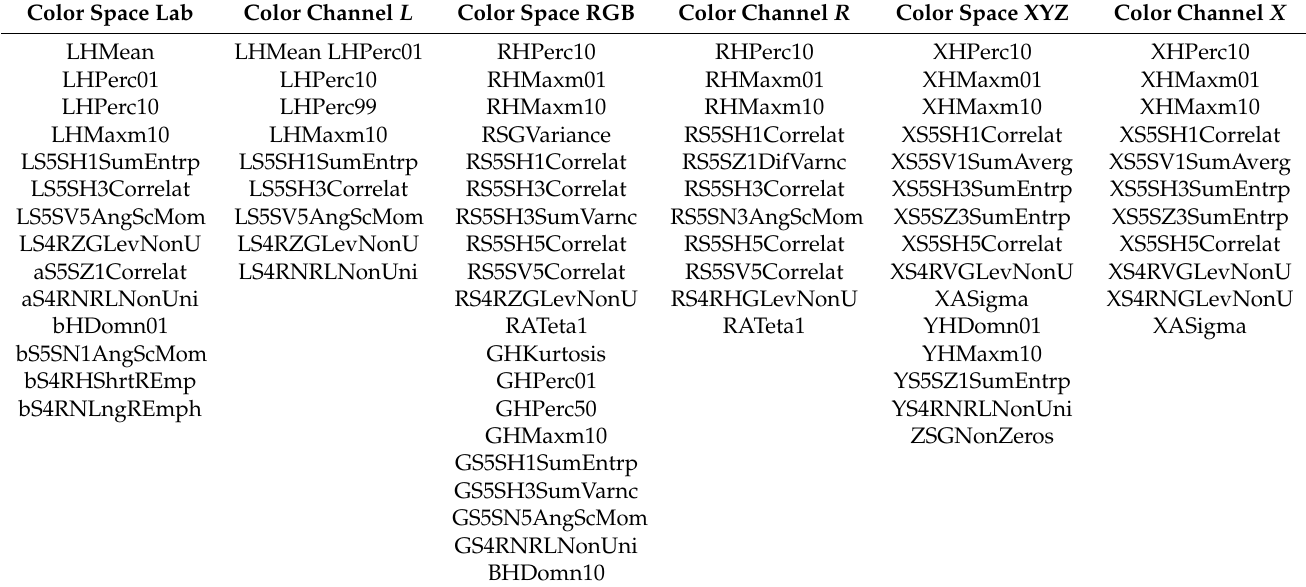
Table 1. The selected texture parameters used to develop the models to distinguish fresh and lacto-fermented red bell pepper